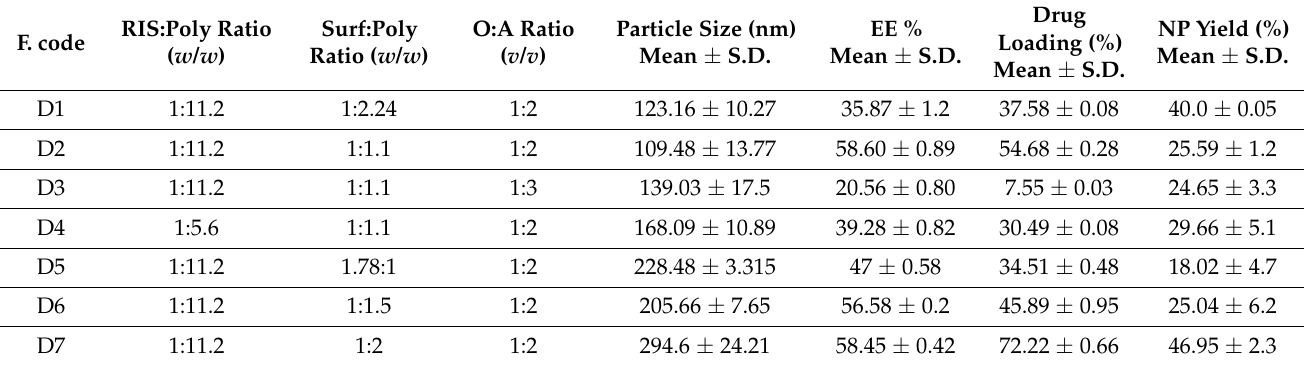
Table 1. Comparison of particle sizes and EE (%) of RIS-loaded PLGA NPs with different formulation ratios ( n =